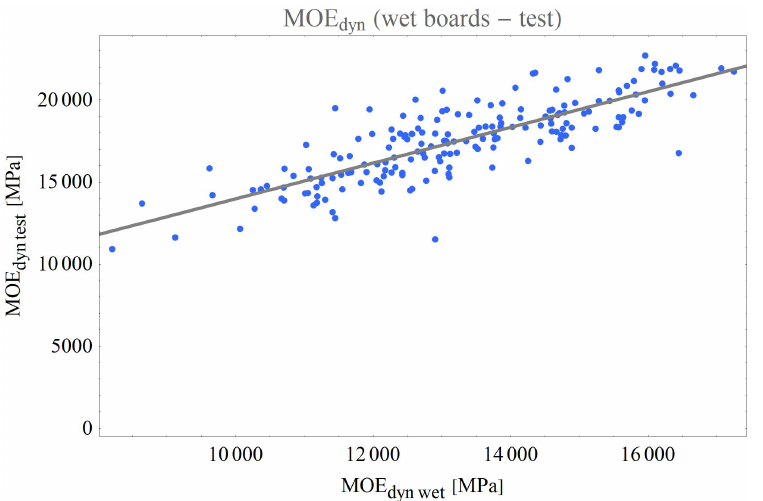
Figure 9. Comparison of the dynamic MOE of boards at the time of tension testing and wet